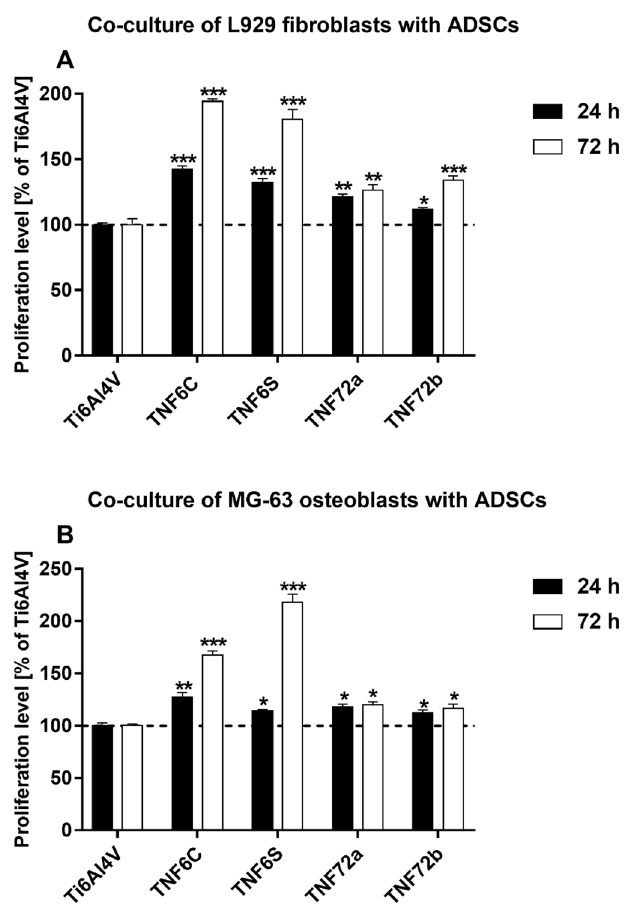
Figure 6. Proliferation level of L929 murine fibroblast cells ( A ) or human osteoblast-like MG 63 cells ( B ) co-cultured with human adipose-derived mesenchymal stem cells (ADSCs) on the surface of fibrous nanocoatings. Cell viability level was assessed using the MTT assay after 24 and 72 h of culture. The results are expressed as percentage of the both co-cultured cells cultivated on the reference Ti6Al4V alloy foils (served as 100%). The percentage values are expressed as means ± SEM of four independent experiments. Asterisks indicate significant di ff erences at the appropriate time (after 24 or 72 h) between the cells co-cultured on the surface of the tested specimens in comparison with the reference Ti6Al4V alloy foils (Ti6Al4V) (*** p < 0.001, ** p < 0.01; * p < 0.05). The horizontal lines show the proliferation level of the both co-cultured cells growing on the reference Ti6Al4V alloy foils.